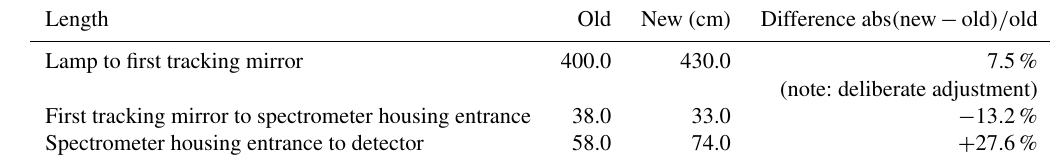
Table 1. Description of the main changes in the path distance used in the past and the current ones. Length Old New (cm) Difference abs ( new − old )/ old Lamp to first tracking mirror 400.0 430.0 7.5% First tracking mirror to spectrometer housing entrance 38.0 33.0 Spectrometer housing entrance to detector